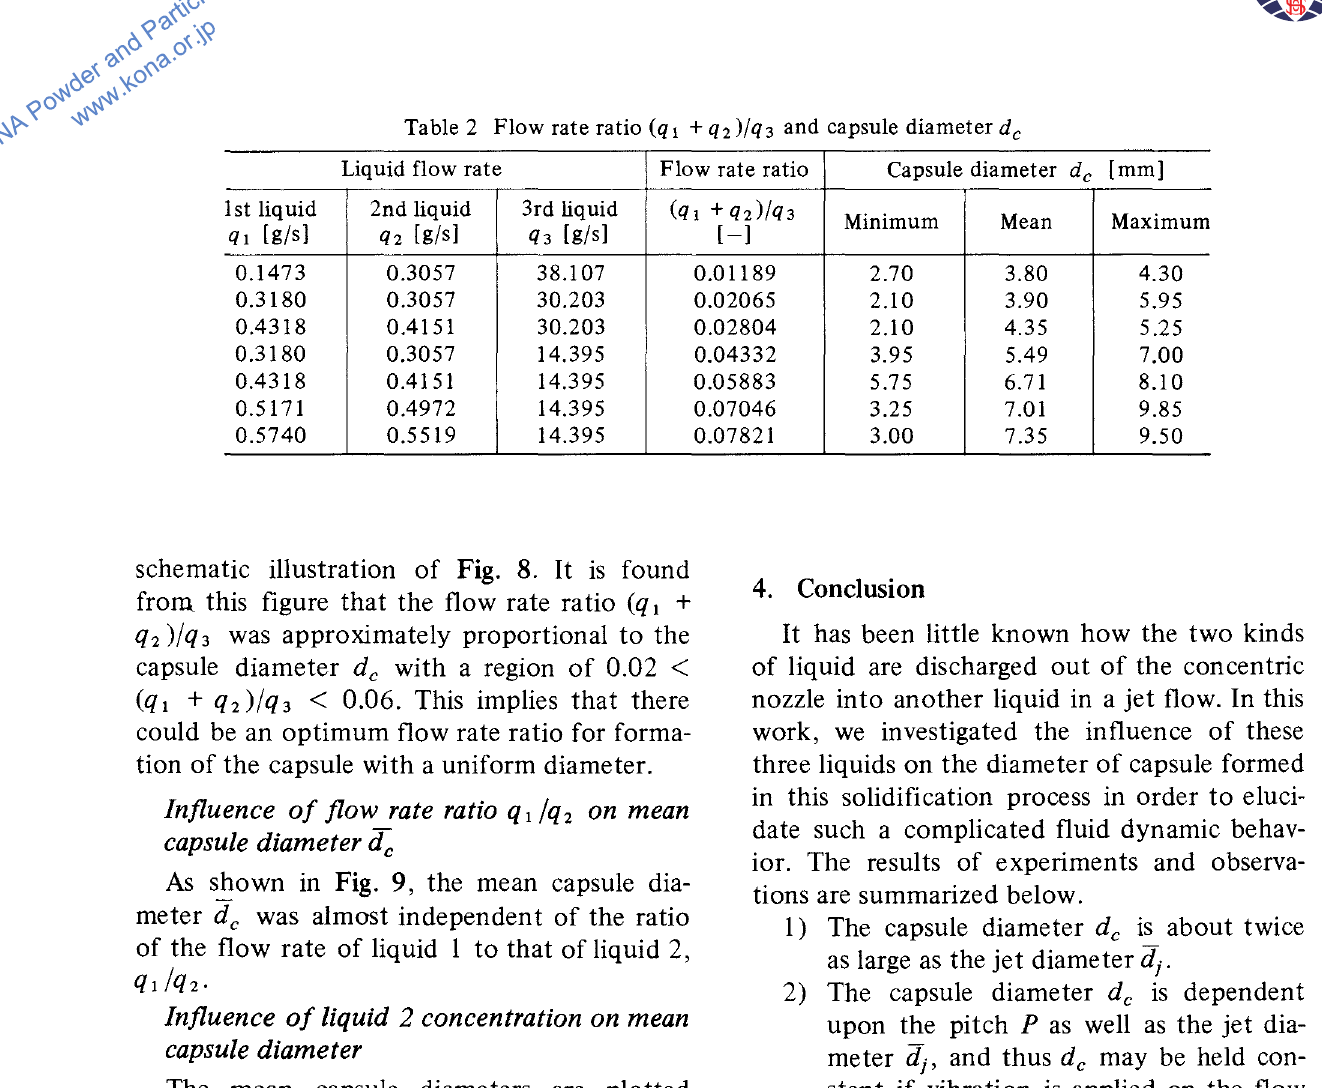
Table 2 Flow rate ratio (q